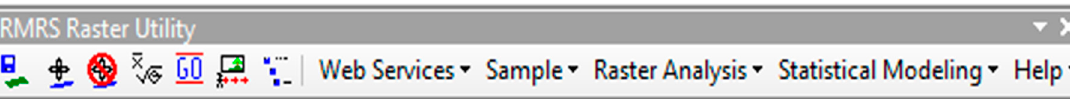
Figure 9. The RMRS Raster Utility toolbar is a free, public source, object oriented library packaged as an ESRI add-in that simplifies data acquisition, raster sampling, and statistical and spatial modeling, while reducing the processing time and storage space associated with raster analysis.